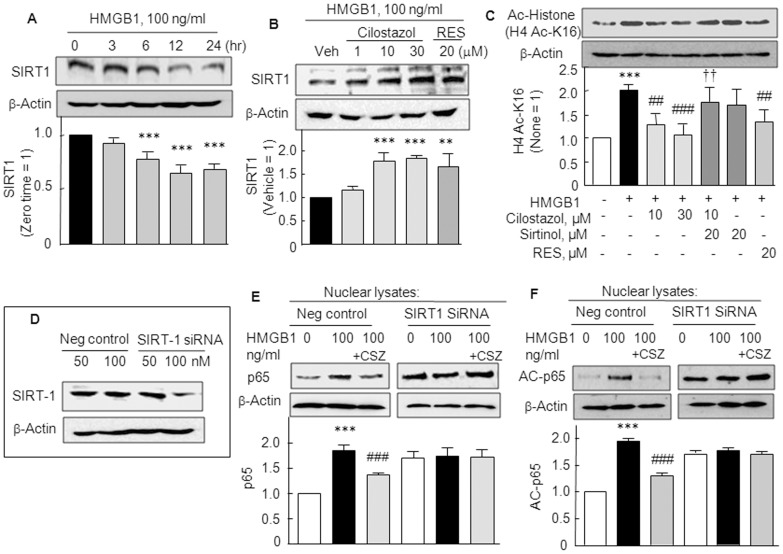
Increased SIRT1 expression and deacetylase activity by cilostazol.(A) Time (3–24 hr)-dependent decrease in SIRT1 protein expression after exposure to HMGB1 (100 ng/ml), and (B) recovery of reduced SIRT1 expression by cilostazol (1–30 µM) and by resveratrol (RES, 20 µM). (C) HMGB1-induced increase in H4 acetyl-k16 (H4 Ac-K16) immunoreactivity was decreased by cilostazol (10 and 30 µM) and resveratrol (RES, 20 µM). Cilostazol-induced decrease in H4 Ac-K16 was prevented by sirtinol (20 µM). (D) Analyses of SIRT1 knockout RA SFs compared with negative control cells. Cilostazol (10 µM) failed to induce expression of SIRT1 in RA SF cells transfected with SIRT1 siRNA oligonucleotide (100 nM) as contrasted to negative control. (E and F) Loss of the effect of cilostazol on the elevated expressions of p65 and acetyl (AC)-p65 induced by HMGB1 (100 ng/ml) in SIRT1 gene silenced fibroblasts, which contrasted to the effects of cilostazol in the negative control cells. Results are the means ±SEM of 4 experiments. **P<0.01, ***P<0.001 vs. no treatment or vehicle (Veh); ##
P<0.01, ###
P<0.001 vs. HMGB1; ††
P<0.01 vs. 10 µM cilostazol.